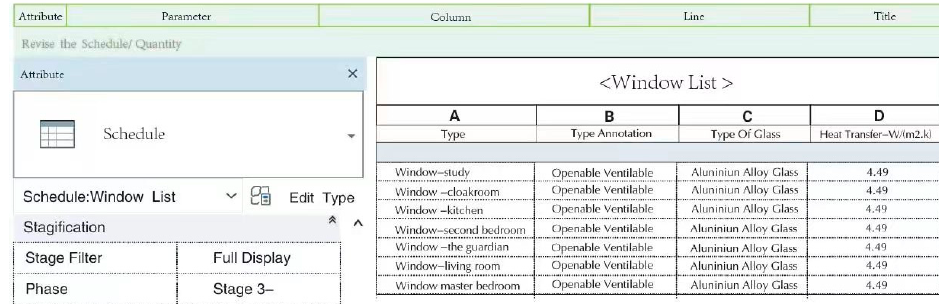
Figure 8. Analysis results of thermal comfort PPD in each area of a decoration project in Xuzhou.